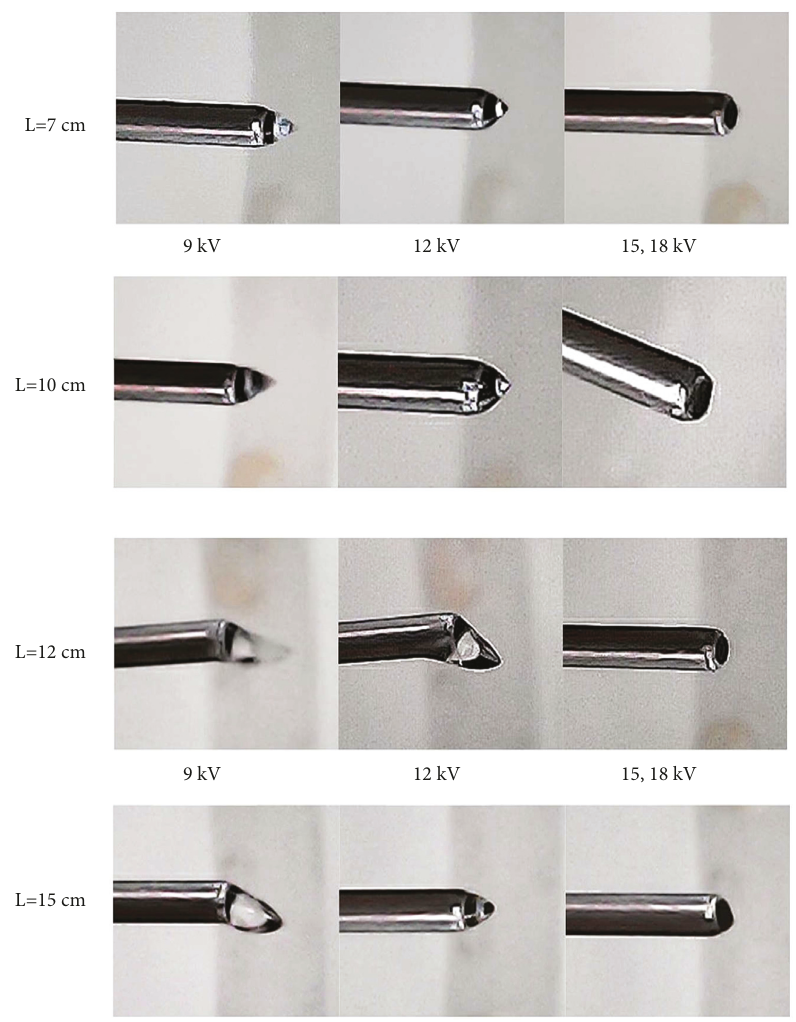
Figure 11: Images of the droplets of 1.5 wt.% M3 chitosan concentration in 90 wt.% acetic acid concentration changing in different voltage (U) and distance (L).